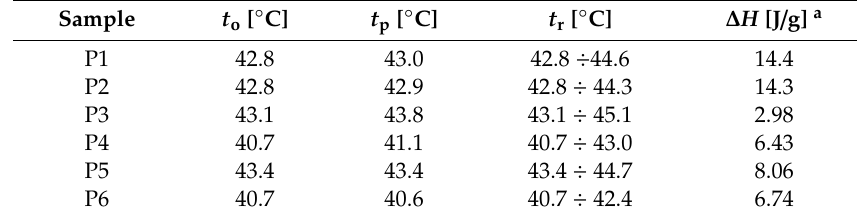
Table 2. Results of Differential Scanning Calorymetry (DSC) measurements of aqueous solutions of homopolymers (1.5% w / w ). The temperatures given below corresponds to: t o —onset of the peak, t p —minimum of the peak and t r — range of temperatures within the transition occurs. The phase transition enthalpies ∆ H have been estimated as the areas of the endothermic peaks corresponding to the phase transitions.